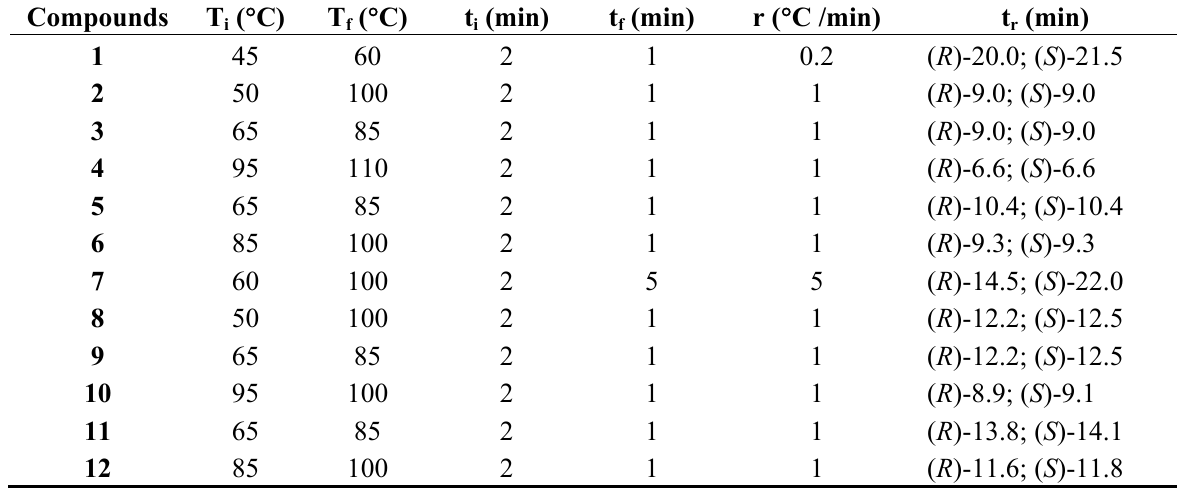
Table 2. Programs used for identification of the alcohols 1 – 6 and acetates 7 – 12 by GC-FID analyses a . Compounds